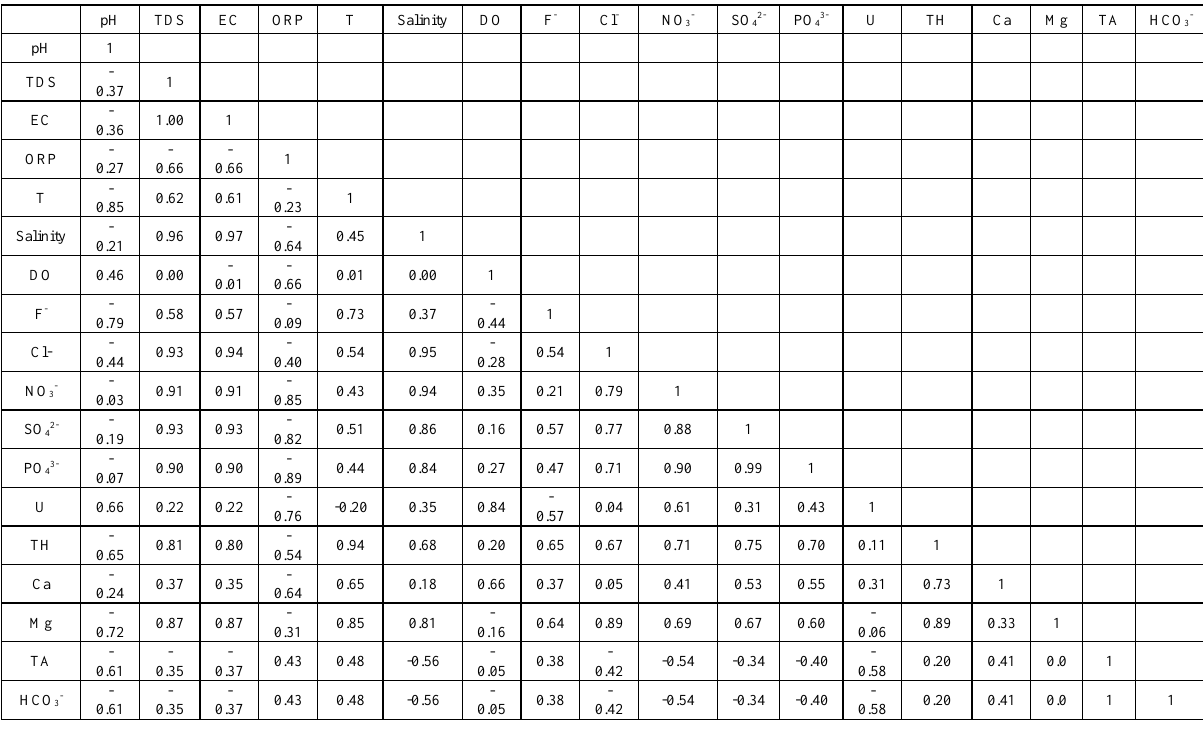
Table 4. Table for correlation in the post-monsoon season